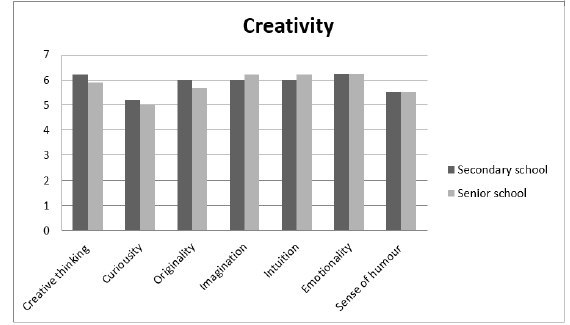
Figure 1. Comparison of the “Creativ - ity” test results in groups of secondary and high school students